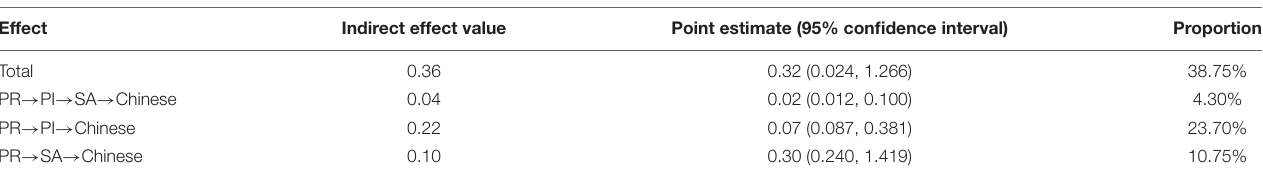
FIGURE 2 | Model result. Chinese primary school students’ peer relationship and Chinese language scores: the chain mediation effect of parental involvement and sense of autonomy. ∗∗∗ p < 0.001; n = 1503. TABLE 2 | Effect sizes with parental involvement and sense of autonomy as